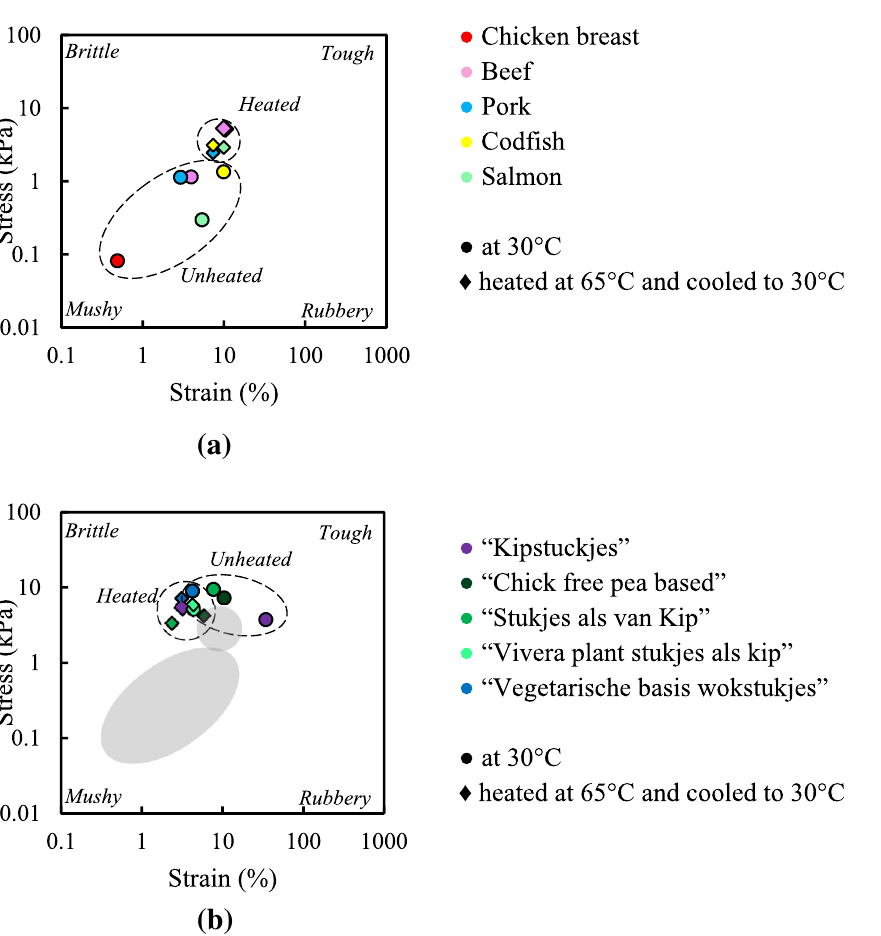
Figure 2. Texture map at the end of the LVE regime for meat ( a ) and meat analogues ( b ) heated at 30 °C and heating to 65 °C, and cooling to 30 °C. Lines are drawn to guide the eye and shows the outline. The grey area in the texture map of meat analogues shows the outline of meat products, shown also in the ( a